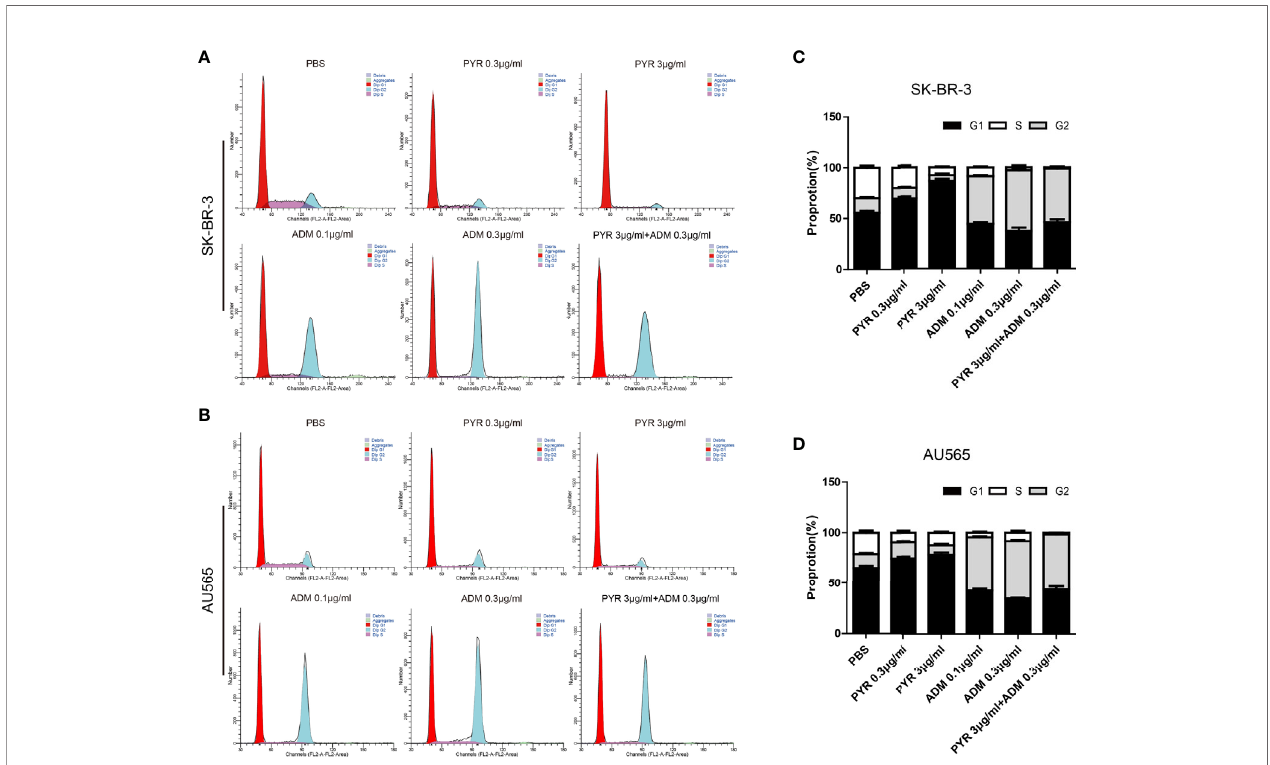
FIGURE 5 | Effects of PYR and ADM on the cell cycle. (A, B) Cell cycle analysis through PI staining and following fl ow cytometry for SK-BR-3 cells after incubated with PBS, different concentrations of PYR(0.3, 3 m g/ml), ADM(0.1, 0.3 m g/ml) or a combination treatment (PYR+ADM) for 24 h. ModFit was used to perform cell cycle analysis. (C, D) The histograms were the representative results, while the fi gure in the right. Compared with the PBS group, PYR caused signi fi cant G1 phase arrest, while ADM caused signi fi cant G2 phase arrest, PYR combined with ADM induces G1/S arrest in SK-BR-3 and AU565 cells. Data represent the mean ± S.D. of three independent experiments.